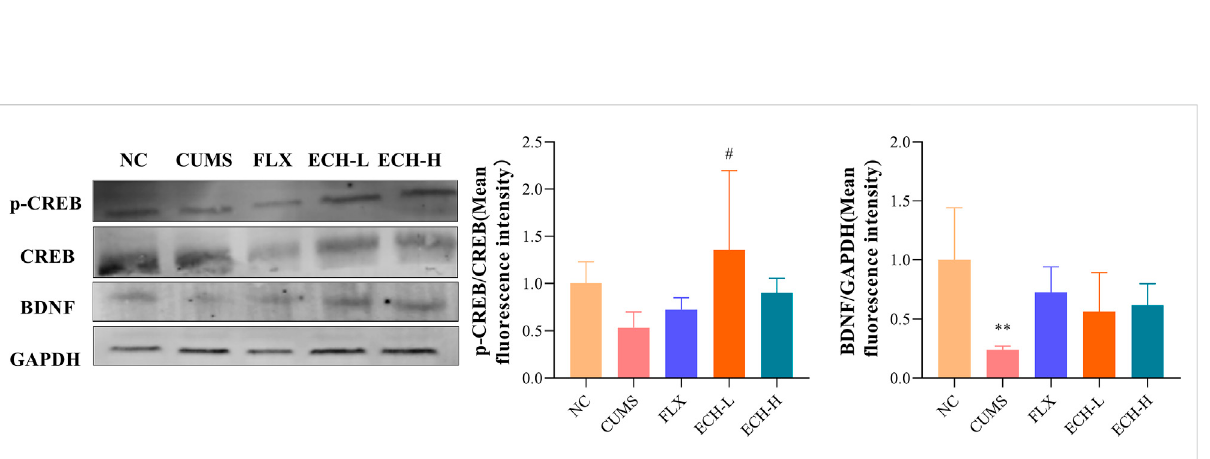
Effects of ECH on key protein expressions in the CREB/BDNF pathway in hippocampus of CUMS Mice. NC, un-treated normal mice; CUMS, mice were treated with the chronic stimulating factors for 7 weeks to set up the CUMS depression model; FLX, CUMS induced mice were administered with fl uoxetine (10 mg/kg,i.g.) daily for 21 days; ECH-L, CUMS induced mice were administered with echinacoside (15 mg/kg,i.g.) daily for21 days;ECH-H,CUMSinducedmicewereadministeredwithechinacoside(60 mg/kg,i.g.)dailyfor21 days n =3/group.** p < .01compared with control group; # p < .05 compared with CUMS